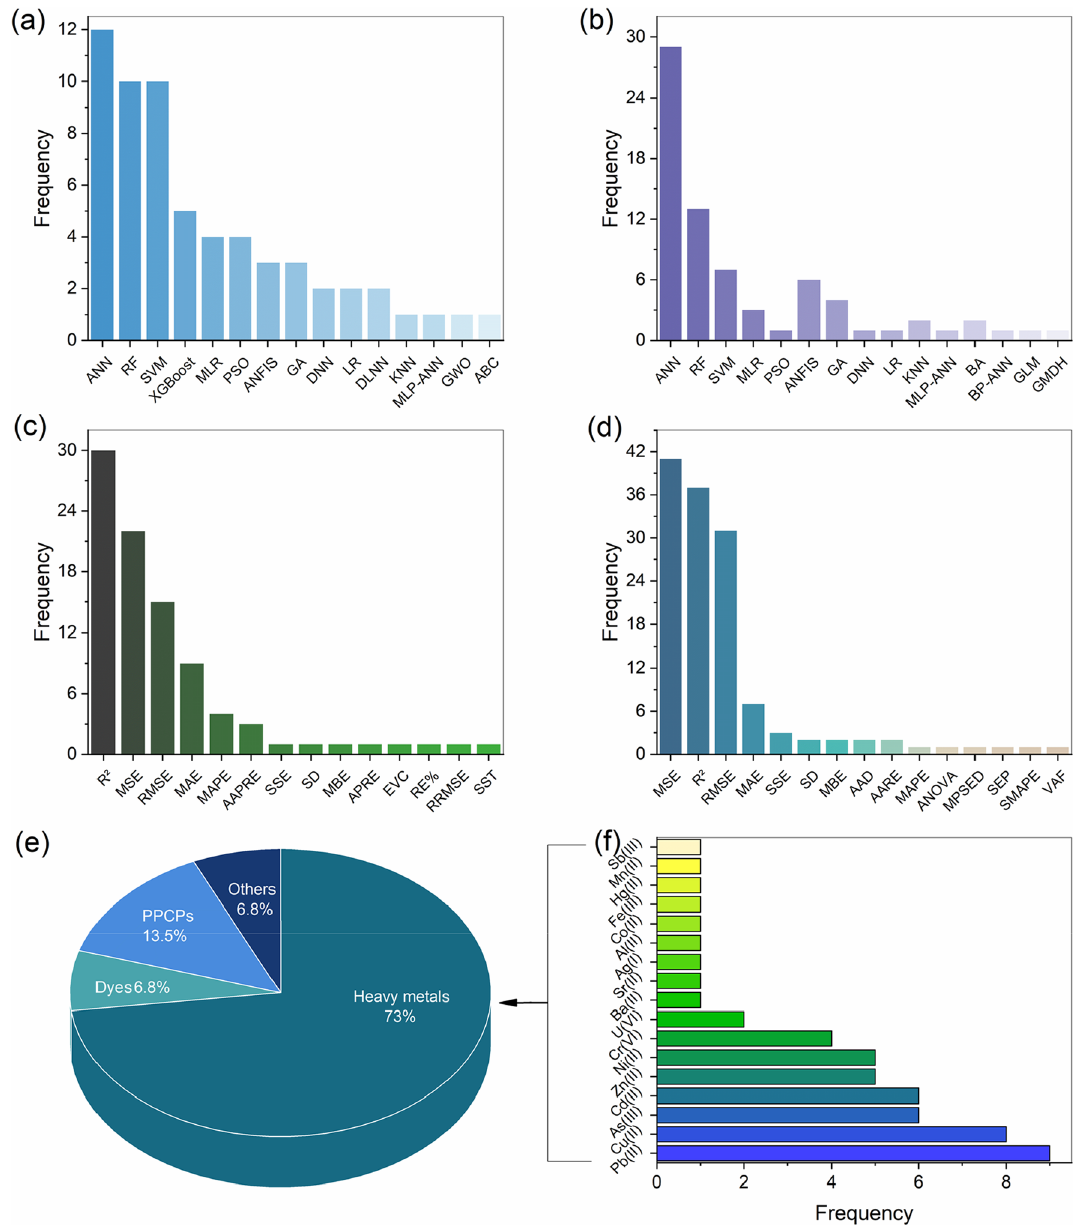
Fig. 5 Comprehensive statistics on the applications of machine learning in optimizing biochar pyrolysis and modeling adsorption process of biochar for pollutant removal. a The frequency of algorithms employed in machine learning for biochar pyrolysis; b The frequency of algorithms employed in machine learning for pollutant removal via biochar; c The frequency of model evaluation indexes employed in machine learning for biochar pyrolysis; d The frequency of model evaluation indexes employed in machine learning for pollutant removal via biochar; e The ratio of pollutants in machine learning for adsorption via biochar; f The frequency of heavy metal elements in machine learning for adsorption via